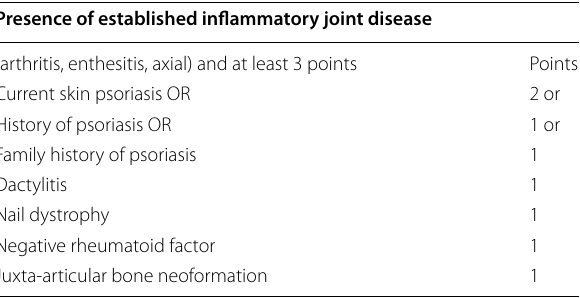
Table 5 Classification criteria for psoriatic arthritis